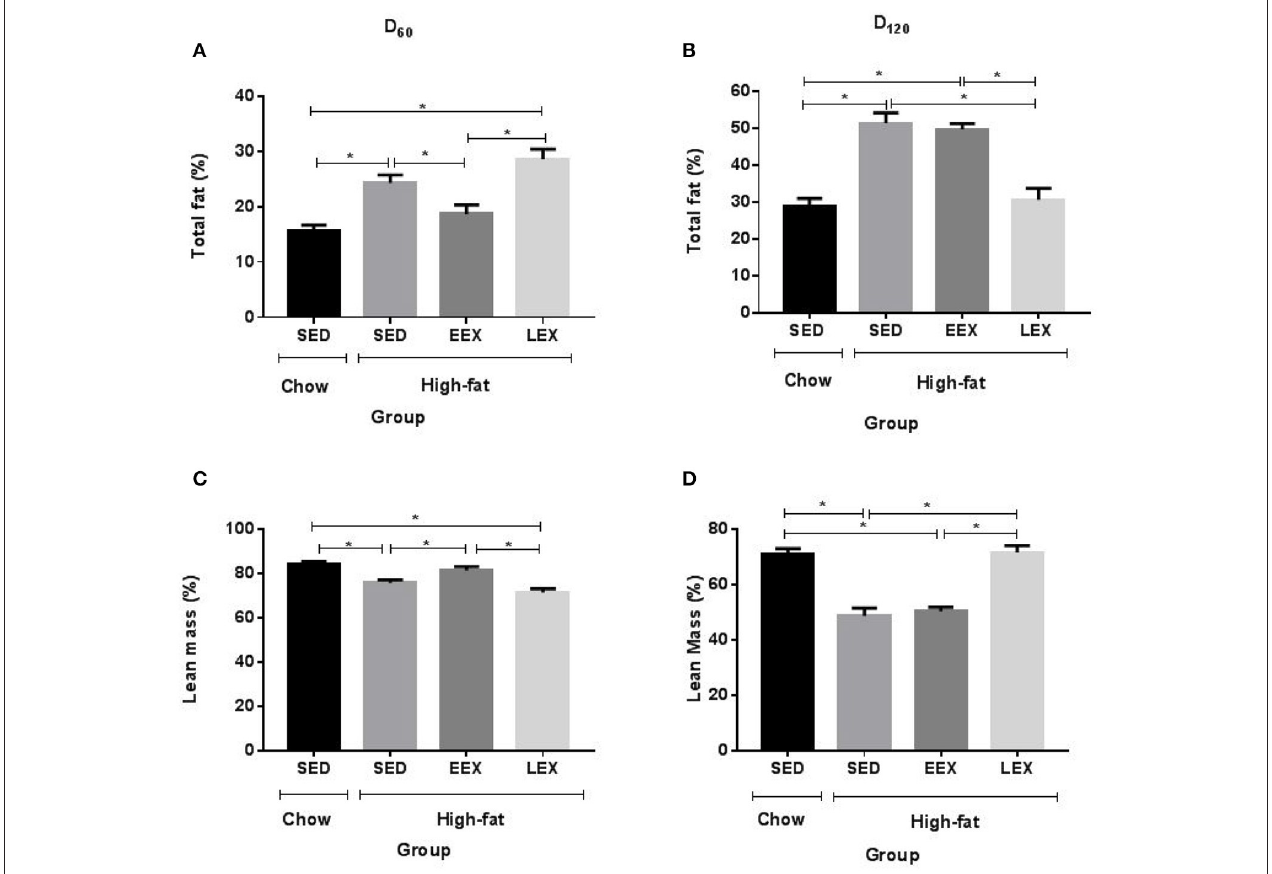
FIGURE 1 | Total fat and lean mass percentage is affected by current but not previous physical activity. (A) Total fat percentage at D 60 (B) Total fat percentage D 120 (C) Lean mass percentage at D 60 (D) Lean mass percentage at D 120 . * P < 0.05. All parameters were analyzed using one-way ANOVA followed by Holm–Sidak method for multiple comparison. SED, sedentary; EEX, early-exercise; LEX,